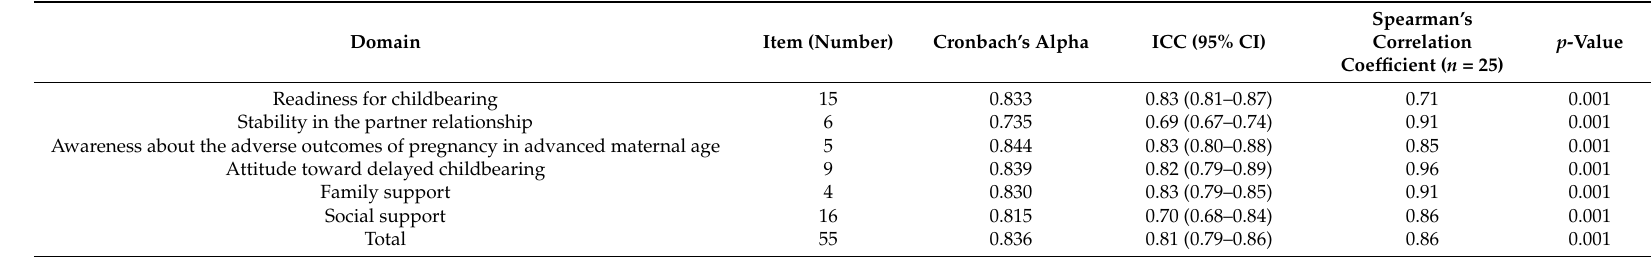
Table 3. Descriptive statistics and reliability measurements of the DCBQ-50. CI = confidence